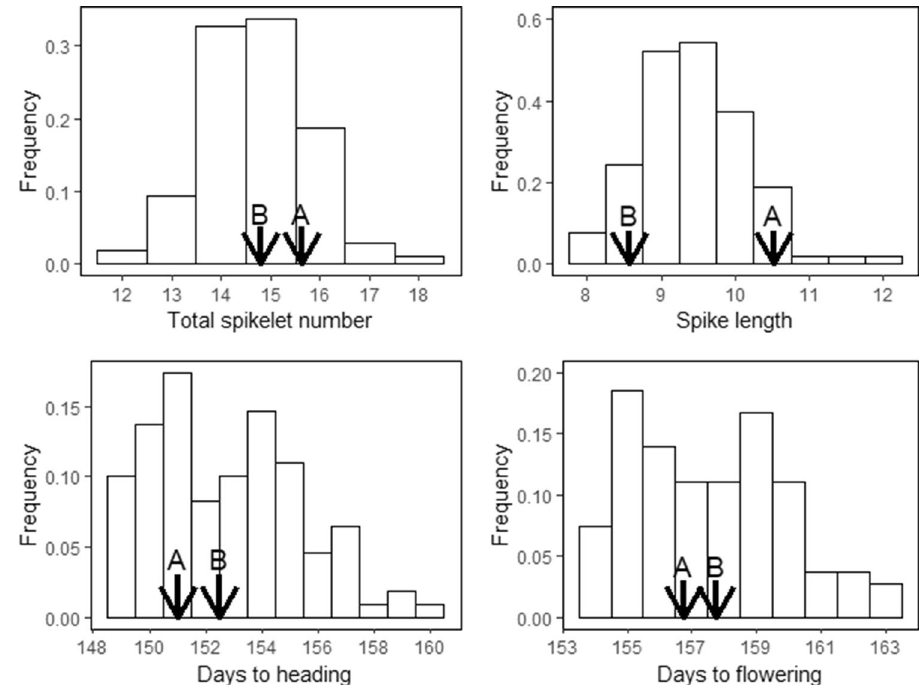
Figure 1. Phenotypic distribution of the best linear unbiased estimations (BLUEs) of the investigated traits. Arrows indicate the phenotypes of the parental lines with parent A corresponding to TRI-10703 and parent B to